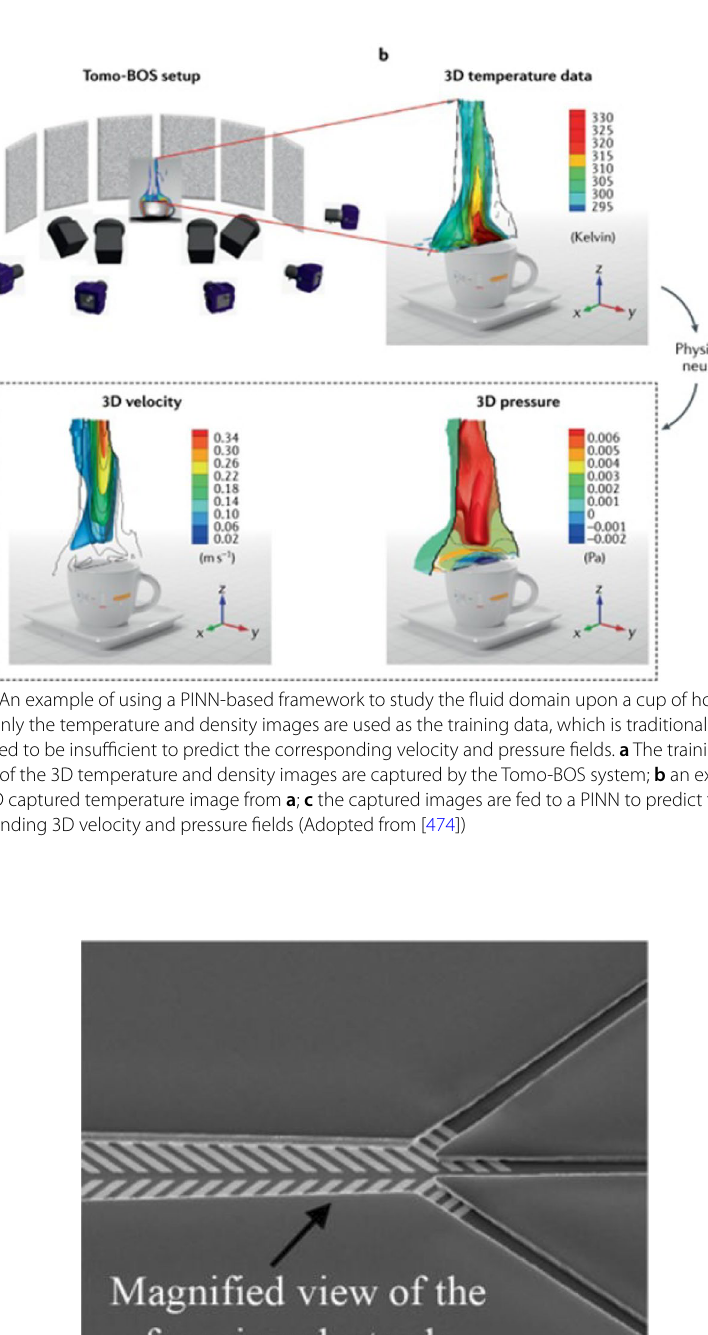
harvesting, Nguyen et al. invented a MEMS electrostatic energy harvester with nonlin- ear springs to enhance the frequency response bandwidth [595]. Their device could gen- erate a power of 85 nW at 560 Hz with a peak amplitude of 0.14 g and a bias voltage